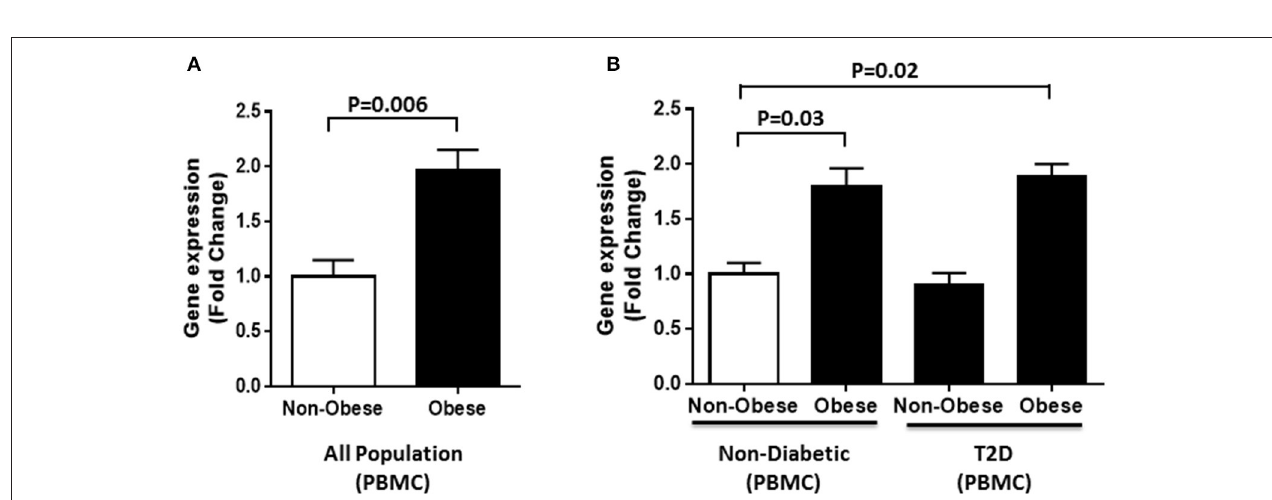
FIGURE 3 | DNAJC27 expression in PBMC comparing obese to non-obese individuals. (A) Expression of DNAJC27 in all population ( n = 60). (B) Expression of DNAJC27 in non-diabetic ( n = 30) and in T2D ( n = 30).